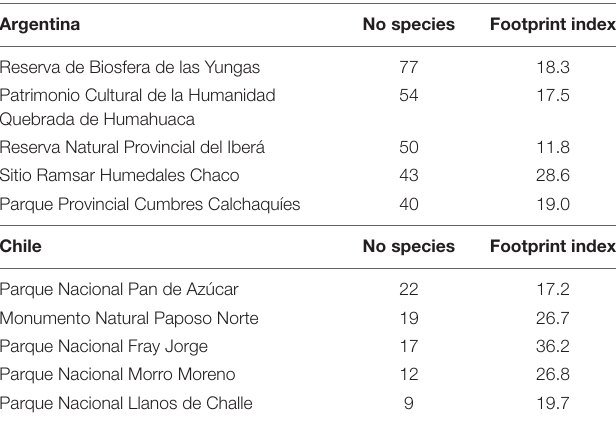
TABLE 1 | Protected areas in Argentina and Chile with the higher number of Solanaceae